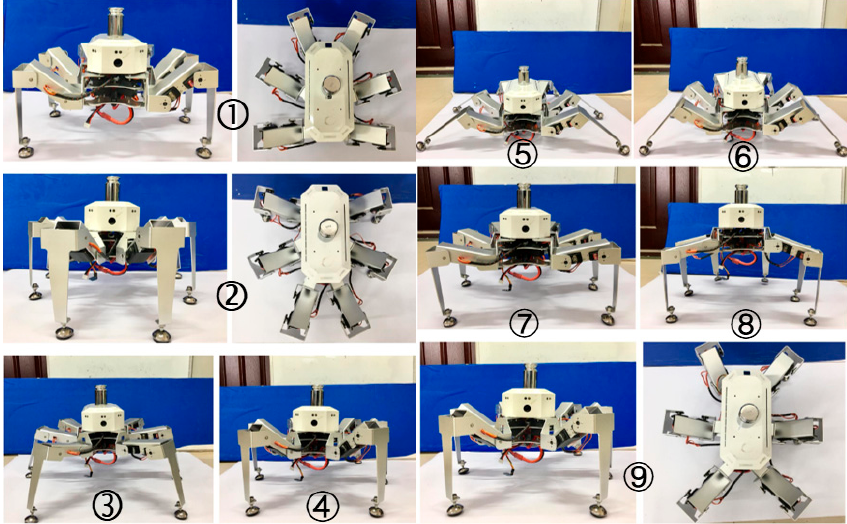
Figure 15. Static postures of robot with consideration of energy consumption and maximum step length. Table 7. Data of Figure 16.